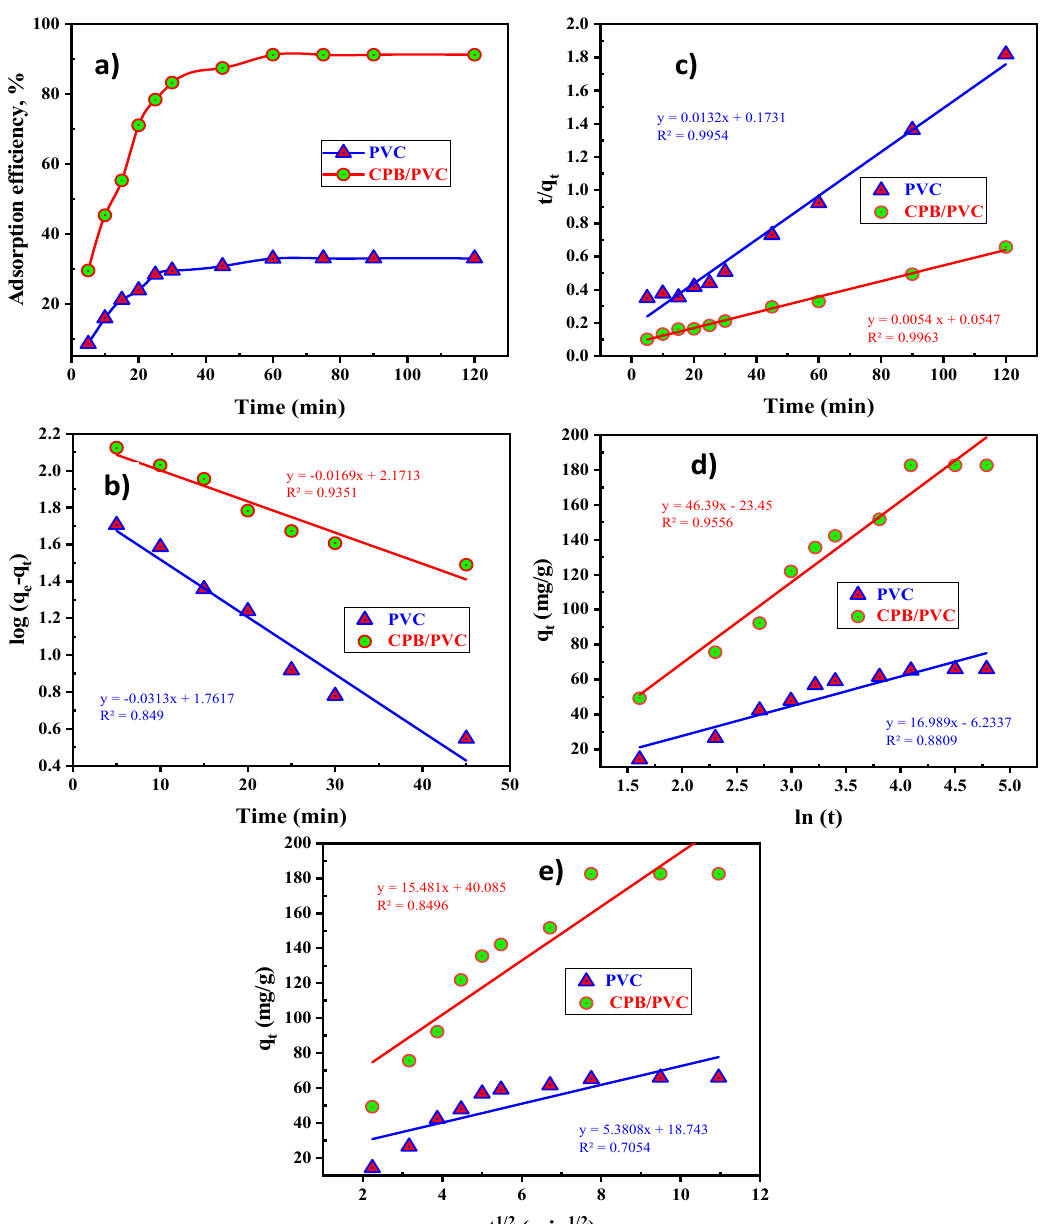
Figure 7. ( a ) Effect of contact time, ( b ) Pseudo-first-order, ( c ) Pseudo-second-order, ( d ) Elovich, ( e ) Intra-particle diffusion models of REE sorption on PVC and CPB/PVC.